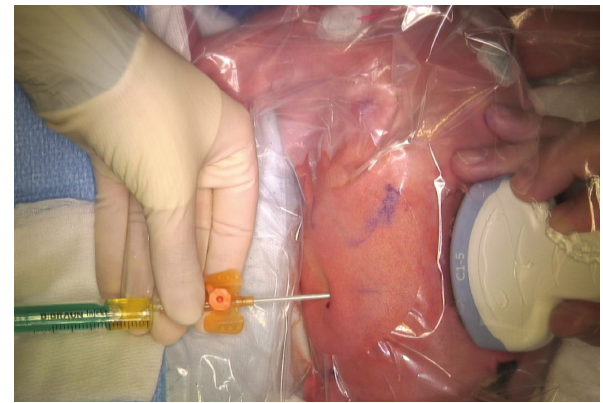
Fig. 3 Pigtail insertion at third day of